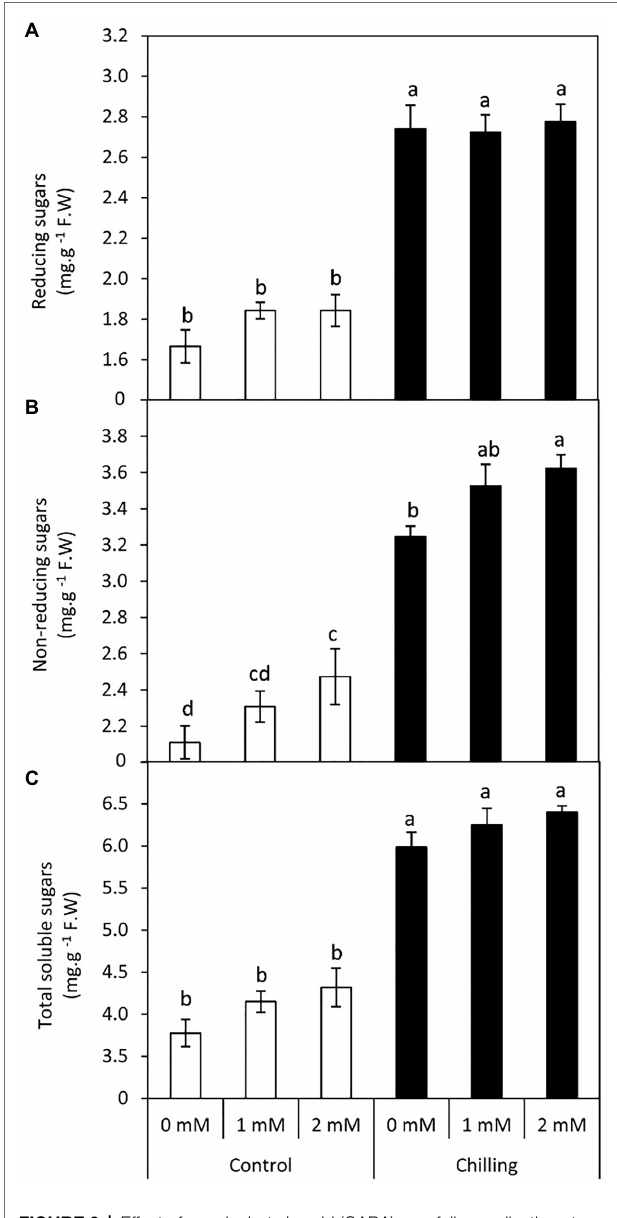
FIGURE 3 | Effect of γ -aminobutyric acid (GABA) as a foliar application at 1 and 2 mM on carbohydrate concentration of tomato plants cv “Super marmende” growing under normal (25°C/20°C day/night ) and chilling conditions (5 days/4ºC for 6 h/day) followed by 2 days recovery. (A) , reducing sugars; (B) , non-reducing sugars and (C) , total soluble sugars. Data followed by the same letters ± SE are not significant according to Duncan multiple rang test at P ≤ 0.05. The white columns refer to the control conditions and the black columns refer to the chilling